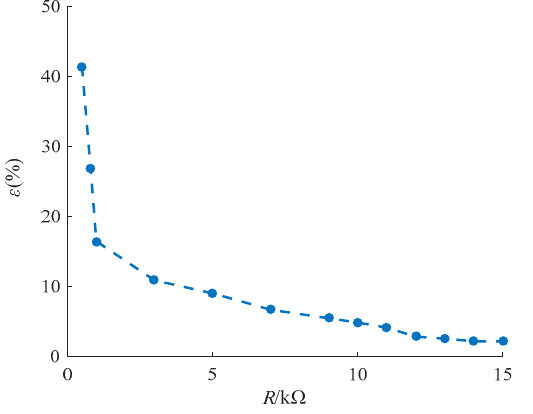
Figure 9. Waveforms of reclosing simulation.